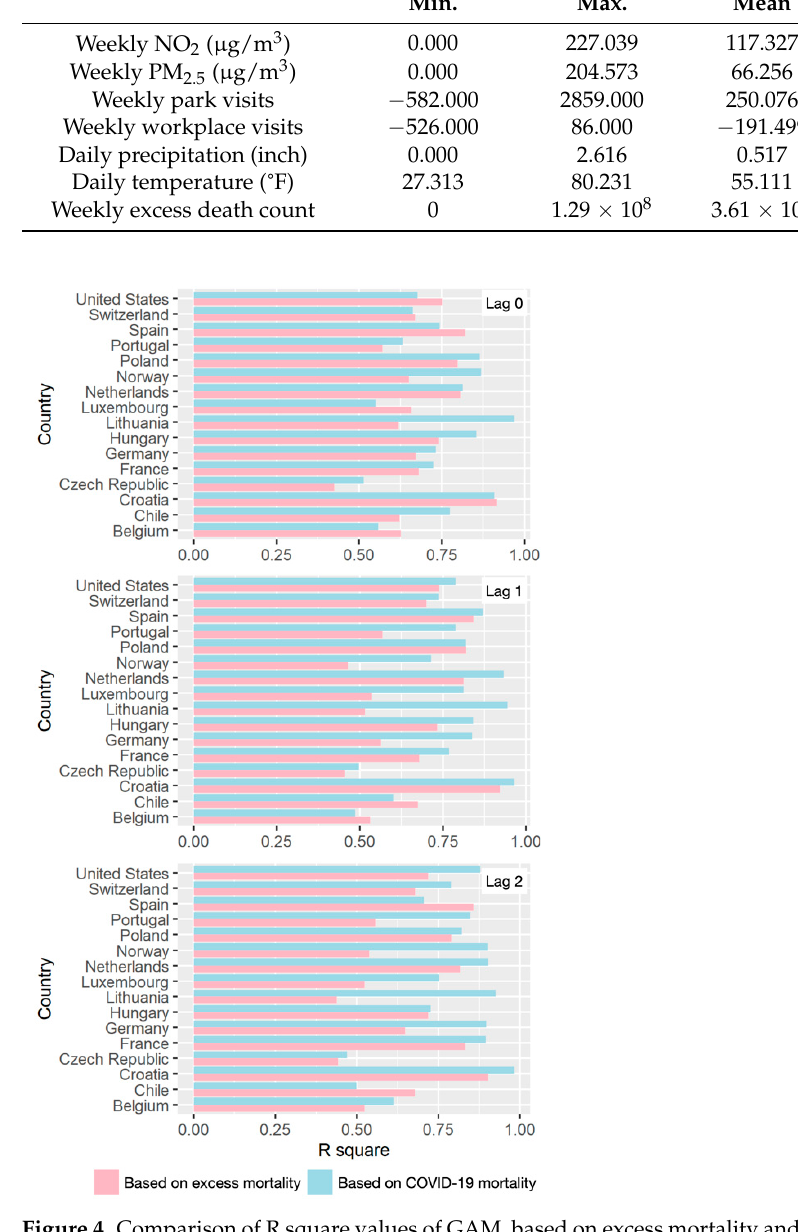
Figure 4. Comparison of R square values of GAM, based on excess mortality and COVID-19 mortality with lag effects of 0,1, and 2 weeks.